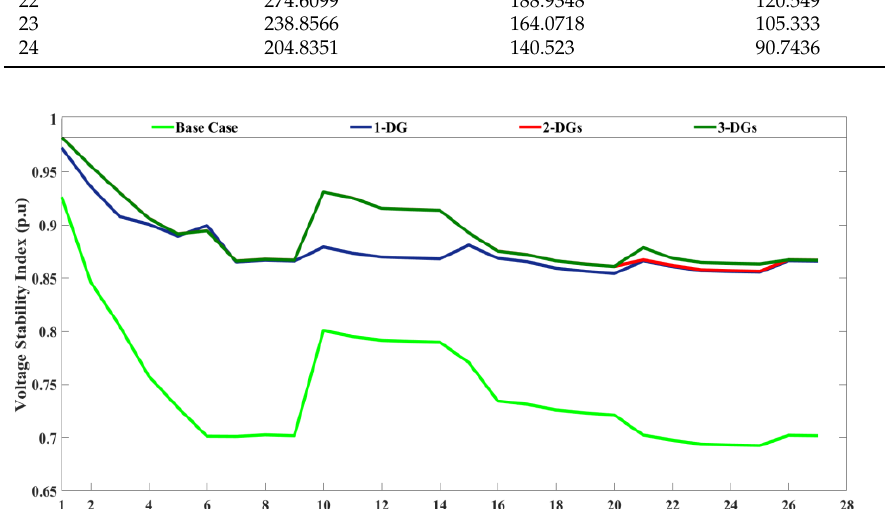
Figure 11. Voltage Profile for 28 Test System.